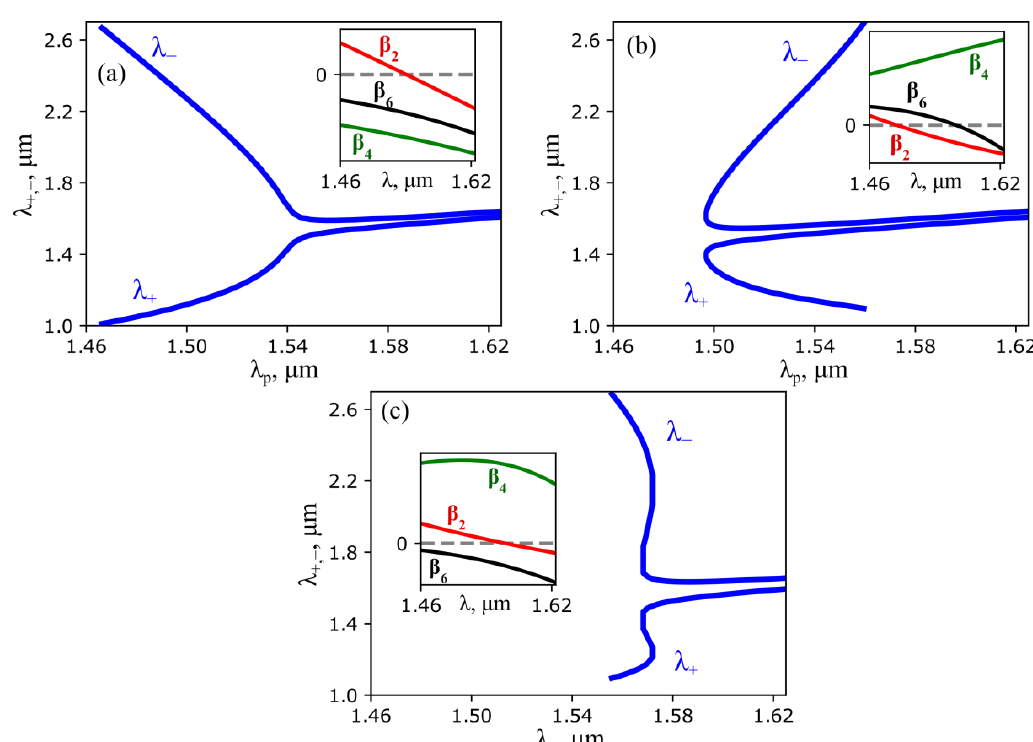
Figure 7. Possible configurations of the phase-matching curves (blue) and schematic plots of β 2 (red), β 4 (green), and β 6 (black) as functions of λ . Microresonator parameters: ( a ) X = 0.8, R = 70 μm, b = 2.7 μm; ( b ) X = 0.8, R = 200 μm, b = 1.6 μm; ( c ) X = 0.5, R = 140 μm, b = 1.7 μm.